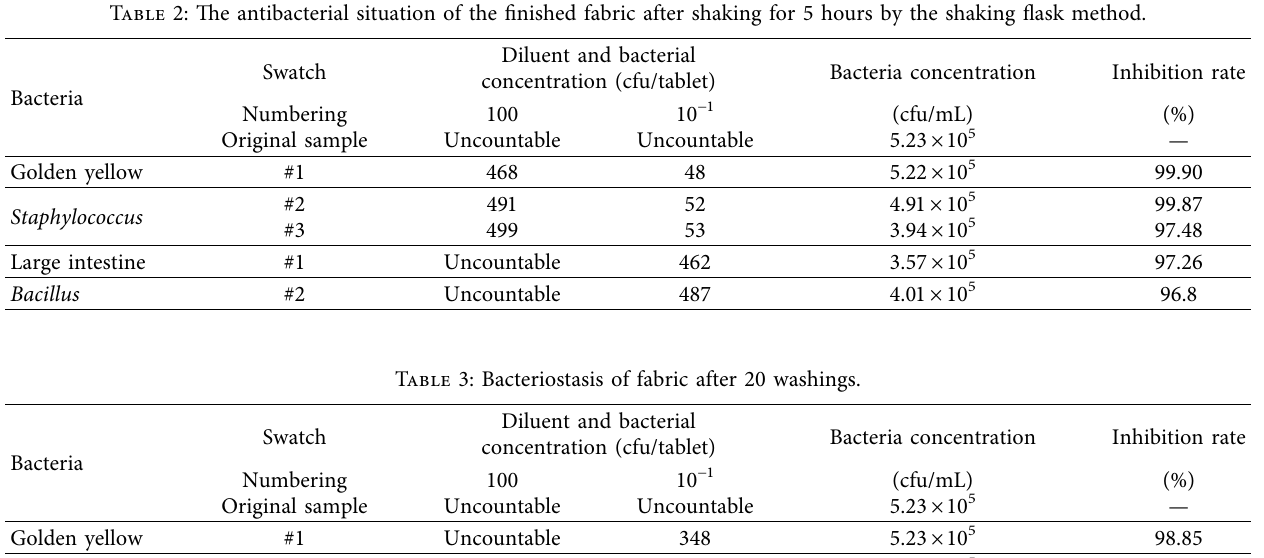
Table 2: The antibacterial situation of the finished fabric after shaking for 5 hours by the shaking flask method.